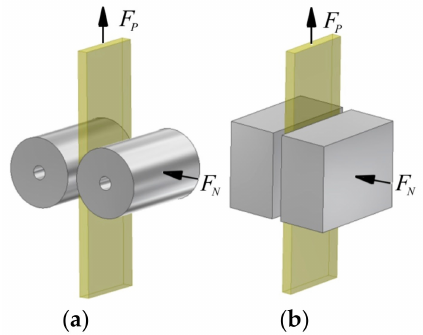
Figure 4. Schematic diagram of the strip-drawing test: ( a ) cylindrical dies and ( b ) flat